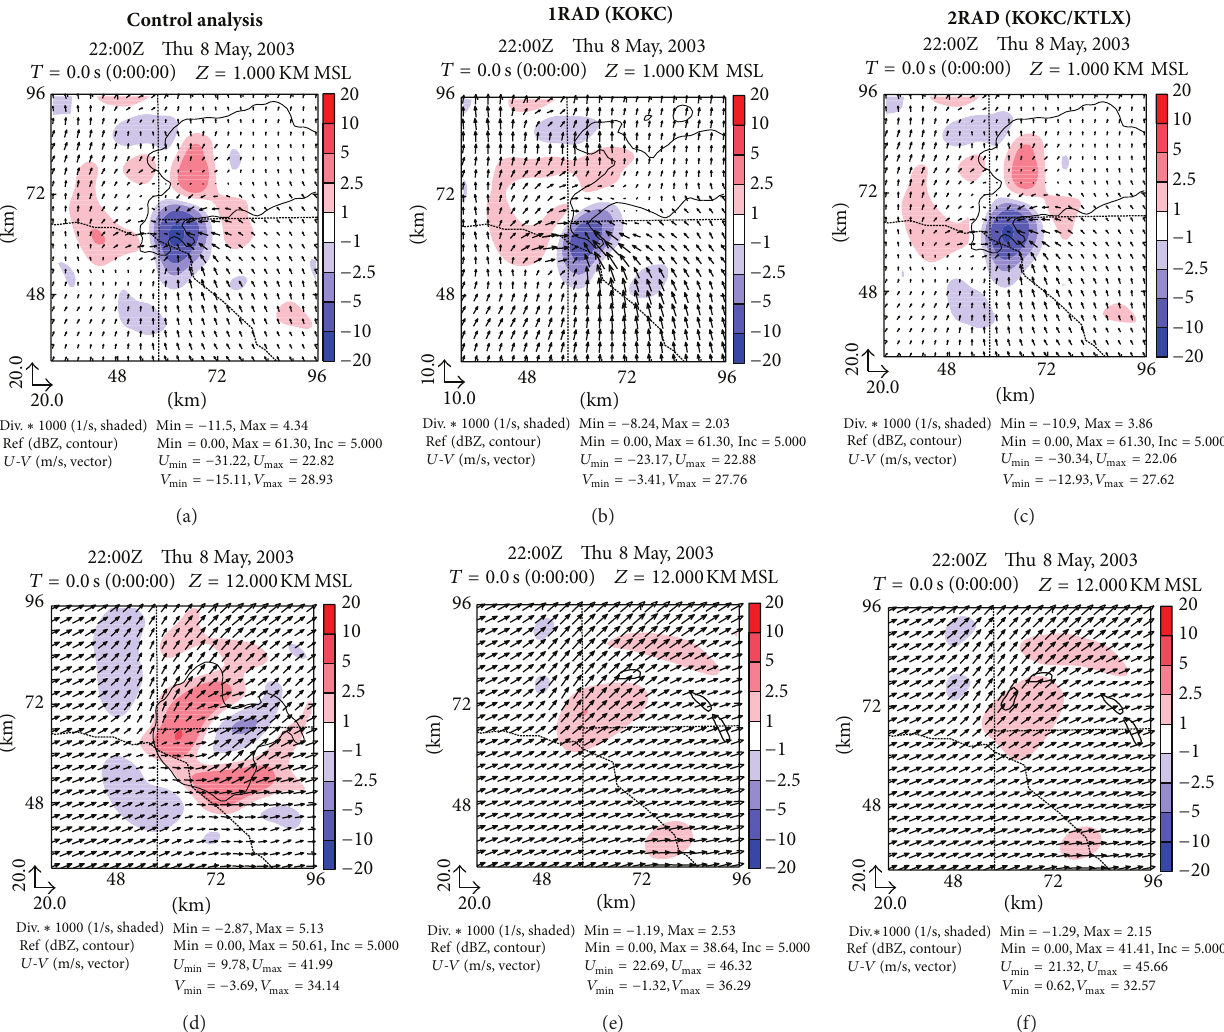
Figure 11: Divergence ( 10 −3 s −1 ) and horizontal wind vectors at 2200 UTC with 35 dBZ reflectivity contour outlined in black for the control analysis at (a) 1km, (d) 12km, and level and for the 1RAD experiment ((b), (e)) and for the 2RAD experiment ((c),